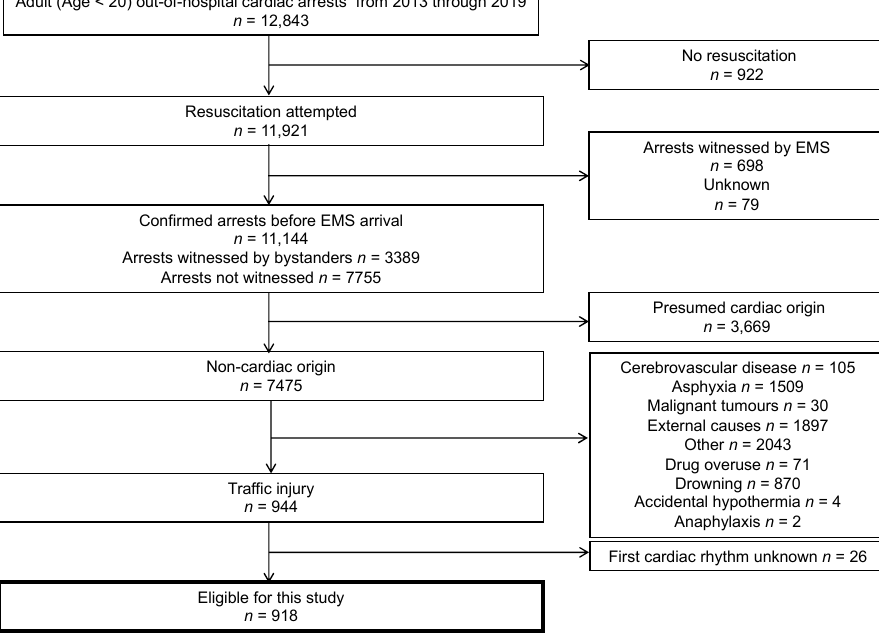
Figure 1. Flowchart depicting the selection of the study population. EMS = emergency medical service.